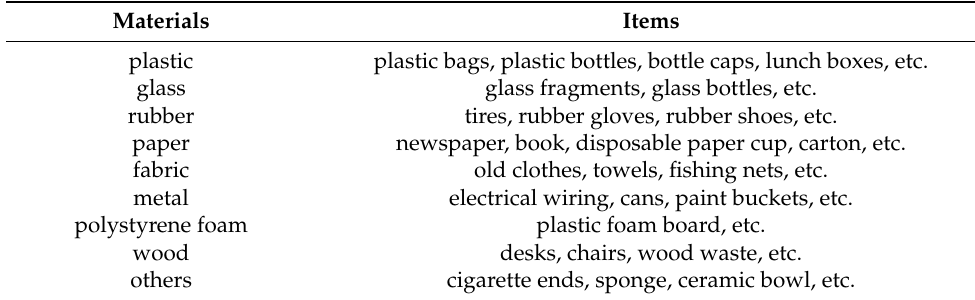
Table 1. Example items of different materials.